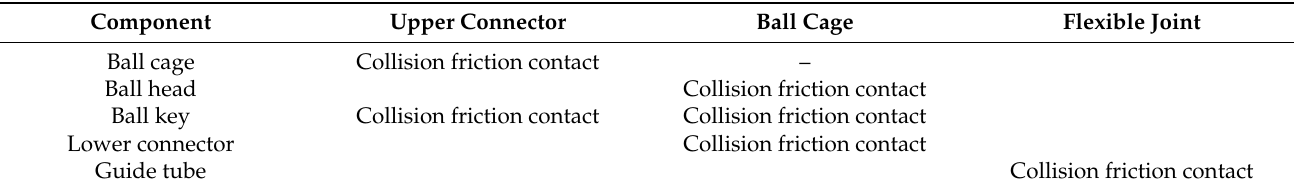
Table 2. Contact relationship of each component of flexible drill